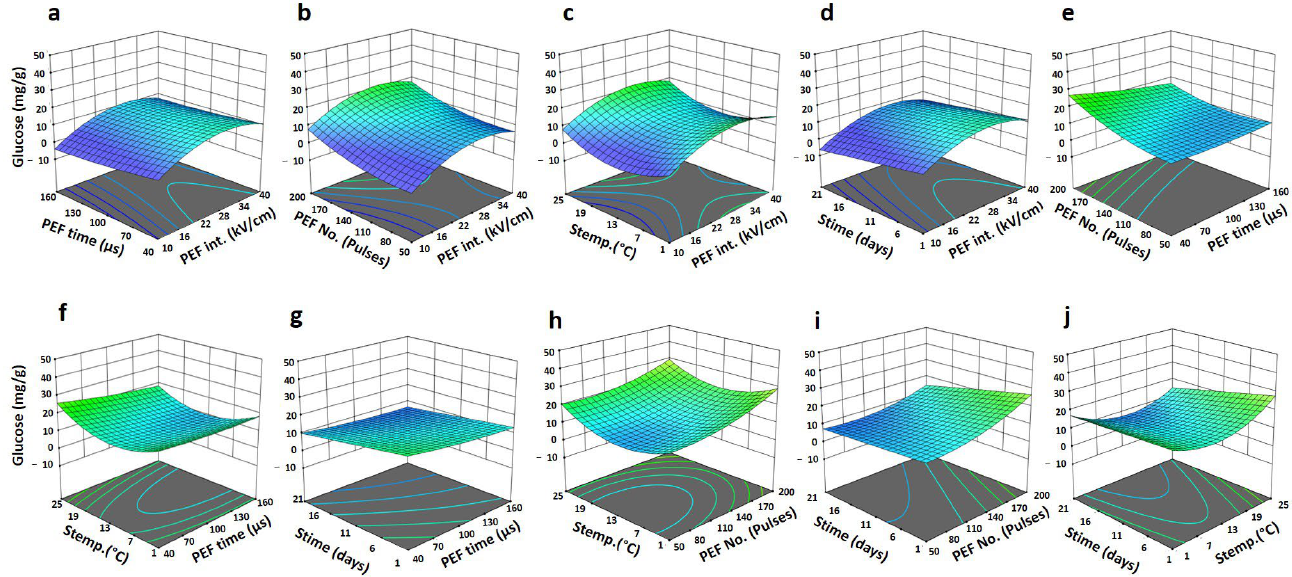
Figure 8. Response surface plots of glucose content of Barhi dates as a function of PEF time and PEF intensity ( a ), PEF number of pluses and PEF intensity ( b ), storage temperature and PEF intensity ( c ), storage time and PEF intensity ( d ), PEF number of pulses and PEF time ( e ), storage temperature and PEF time ( f ), storage time and PEF time ( g ), storage temperature and PEF number of pulses ( h ), storage time and PEF number of pulses ( i ), and storage time and storage temperature ( j ).